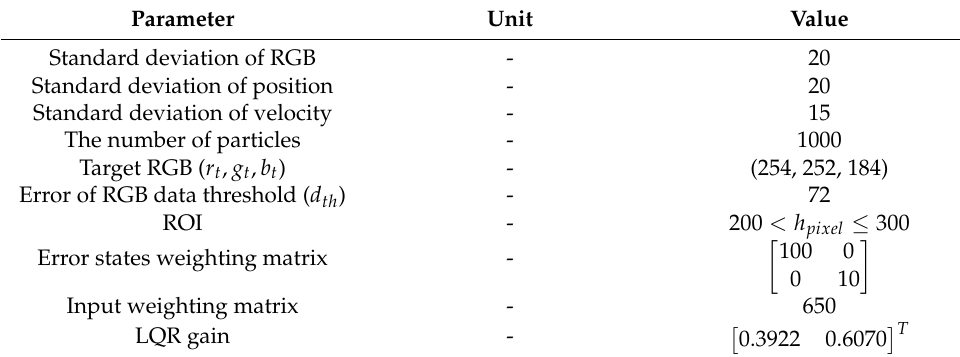
Table 2. Design parameters of the particle filter and